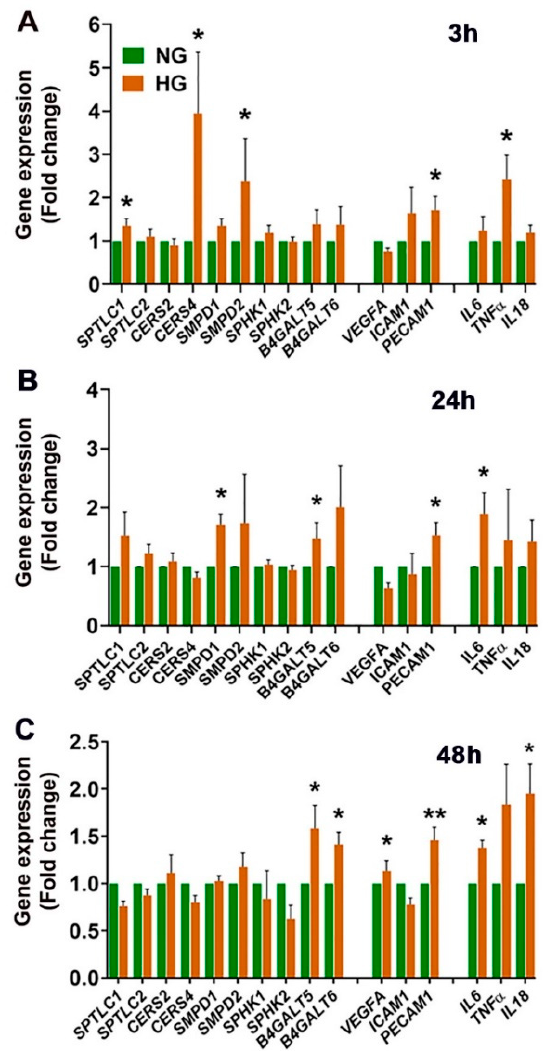
Figure 9. RT-qPCR gene expression analysis of sphingolipid metabolism, vascular proliferation, and inflammatory marker genes in HREC cultured in 5 mM glucose (NG) or 25 mM glucose (HG) conditions for 48 h. Gene expression changes represented as fold change over control (= 1.0) following normalization with two housekeeping genes RPL19 ( ribosomal protein L19 ) and GAPDH ( Glyceraldehyde-3-phosphate dehydrogenase) after cells were cultured for ( A ) 3, ( B ) 24, and ( C ) 48 h in NG and HG. SPTLC1 , Serine palmitoyl transferase 1 ; SPTLC2 , Serine palmitoyl transferase 2; CERS2 , Ceramide synthase 2; CERS4 , Ceramide synthase 4 ; SMPD1, Sphingomyelin phosphodiesterase 1 ; SMPD2, Sphingomyelin phosphodiesterase 2; SPHK1, Sphingosine kinase 1 ; SPHK2, Sphingosine kinase 2 ; B4GALT5, Lactosyl ceramide synthase 5 ; B4GALT6 , Lactosyl ceramide synthase 6 ; VEGFA , Vascular endothelial growth factor A ; ICAM1 , Intracellular adhesion molecule 1 ; PECAM1 , Platelet endothelial cell adhesion molecule 1; IL-6